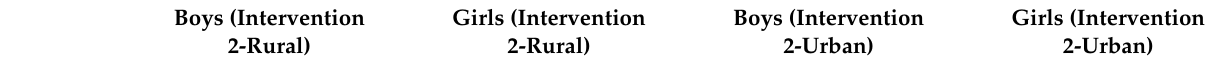
Table 4. Changes, Challenges and Barriers to Healthy Eating at School after the End of The Intervention (Intervention Arms 2- training with food